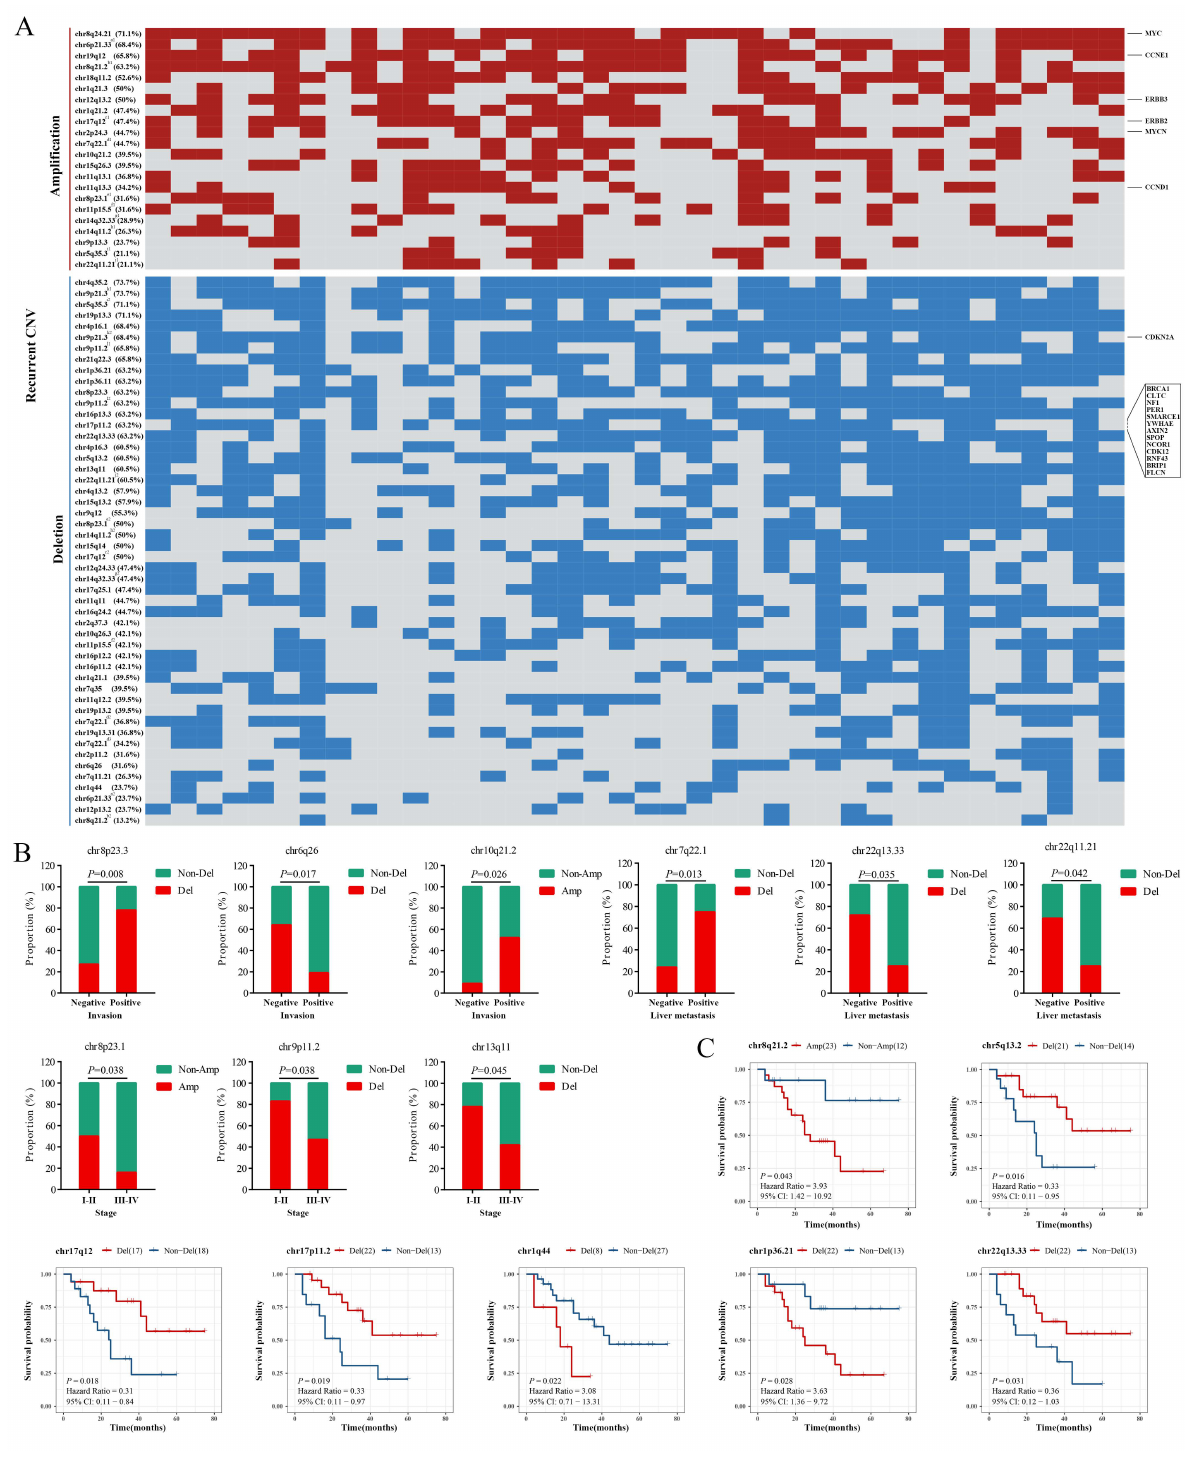
Figure 4. Copy number variants (CNVs) in HAS. ( A ) The heat map shows the recurrent CNVs in HAS. Oncogenes and tumor suppressor genes (TSG) in these regions are marked at the right of the heat map, and the list is provided by the COSMIC database. Red: amplification, blue: deletion. The repeatedly occurred regions marked with a-l are located in different wide peak limits which were recorded in Table S4. The percentage in each row represents the number of samples with the CNVs. Mutated regions are significantly related to ( B ) local vascular invasion, liver metastasis, and advanced stages and ( C ) prognosis. p < 0.05 is statistically